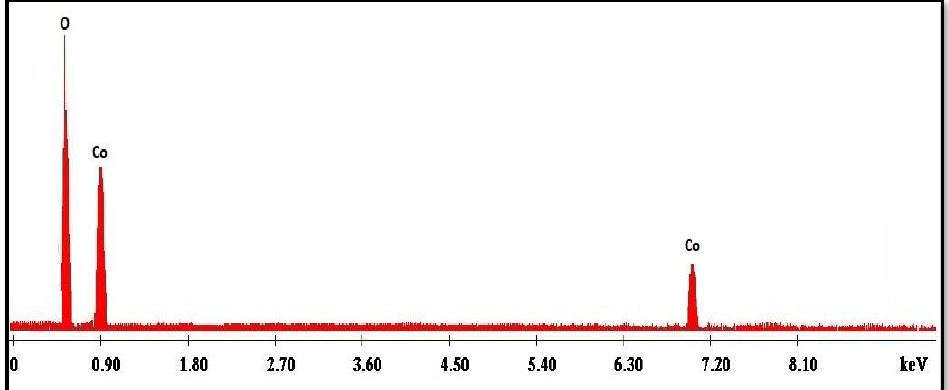
Figure 6. Energy-dispersive X-ray spectrum of the Co 3 O 4 NPs synthesized using rosemary leaf ex- tract.